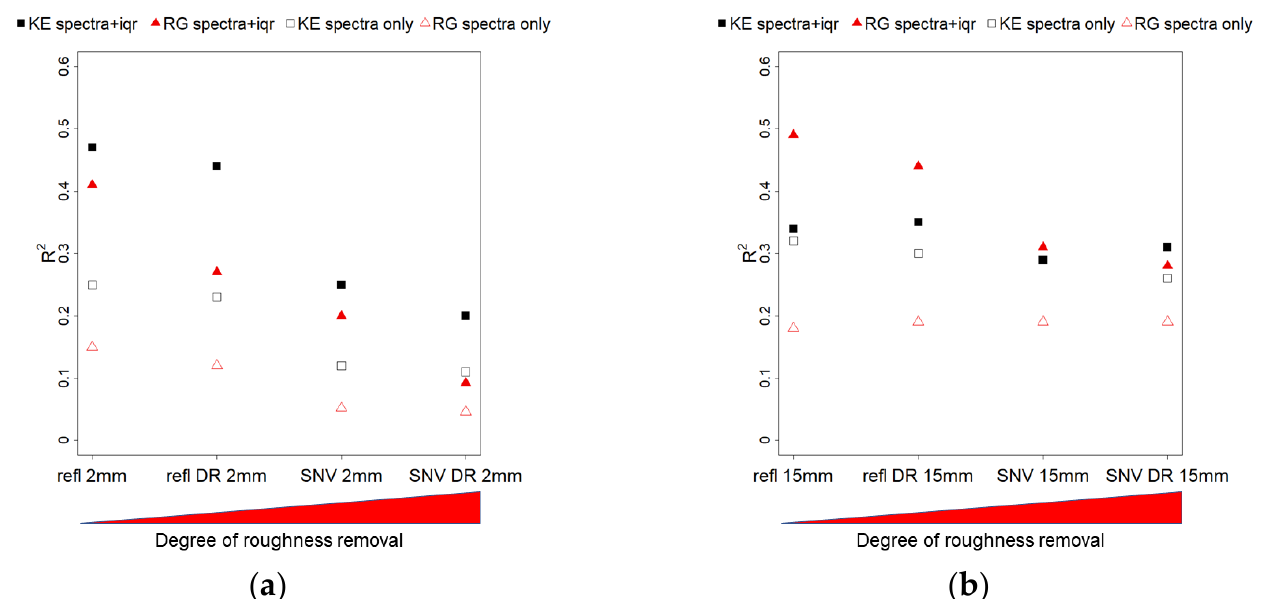
Figure 14. Validation of the PLSR models (using R 2 ) for the different data transformations, ordered by their degree of